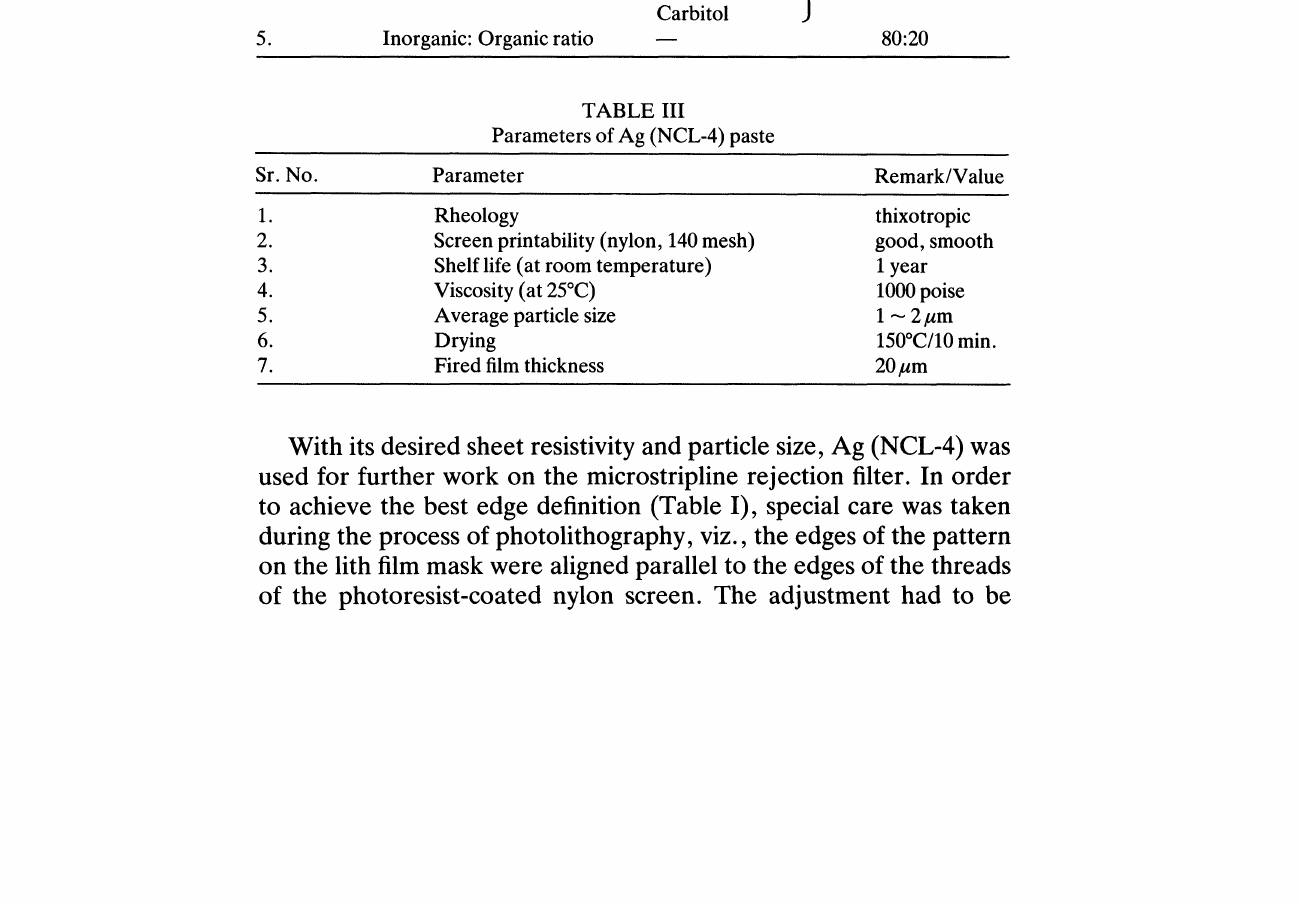
TABLE III Parameters of Ag (NCL-4)